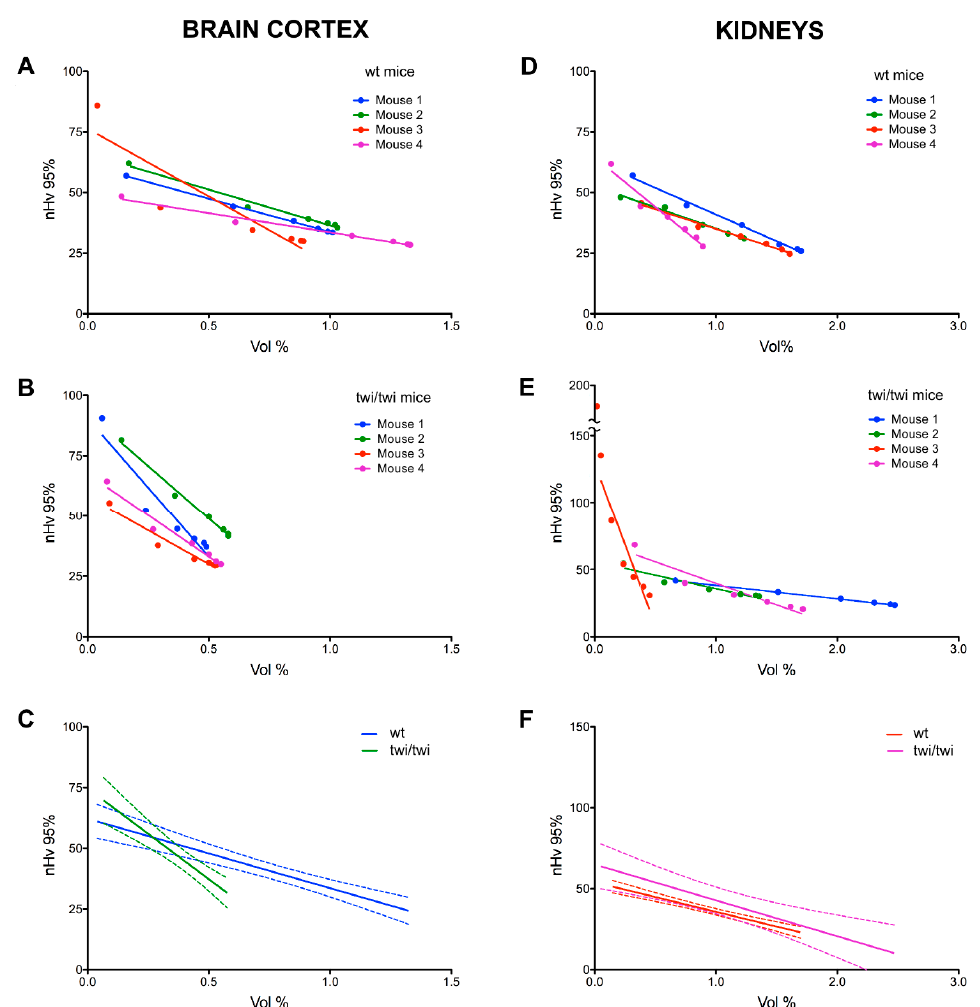
Figure 4. Analysis of brain cortex and renal microvascular angioarchitectures in wt and twitcher mice. Regression lines obtained from microvascular angioarchitectures of brain cortex ( A , B ) and kidneys ( D , E ) of four wt ( A , D ) and four twitcher ( B , E ) mice (one to four z-stacks per animal). Panels ( C , F ) report the median regression lines together with their 95% confidence interval.